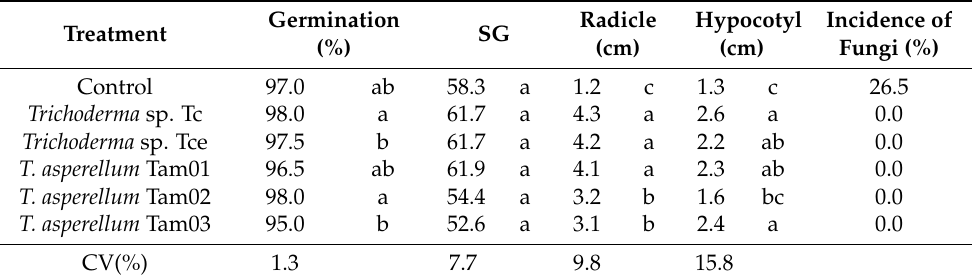
Table 1. Germination and germination speed index (SG) and radicle and hypocotyl lengths of Theobroma cacao seeds treated or not with different Trichoderma isolates. Incidence of fungi represent the % of seed contaminated with other fungi.